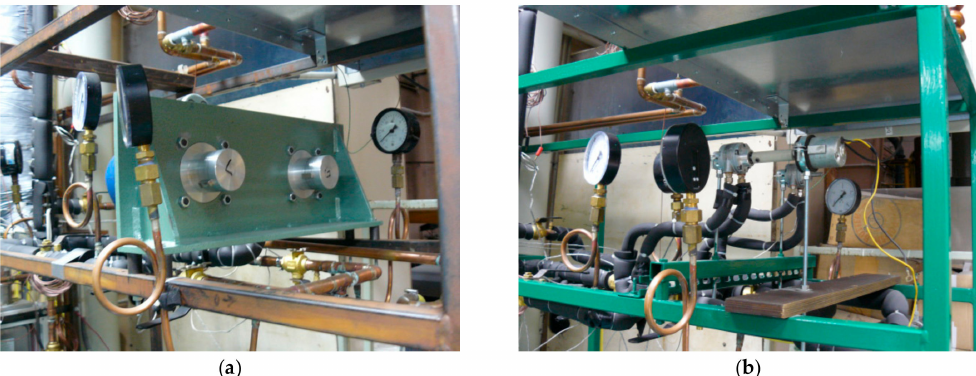
Figure 7. A view of the expanders applied in the test stand implemented in 2009 at the Wrocław University of Technology. ( a ) A view of the expanders, featuring 1.5 kW of power each; ( b ) A view of the expanders, featuring 300 W of power